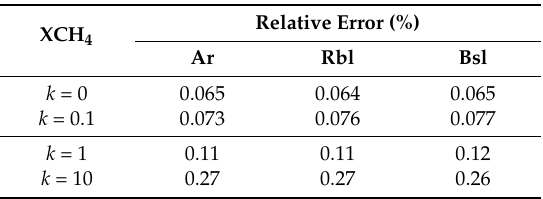
Table A1. Minimum requirement for the accuracy of ρs if the accuracy of AVIRIS -NG retrieved XCH4 reaches that for GOSAT measured XCH4.